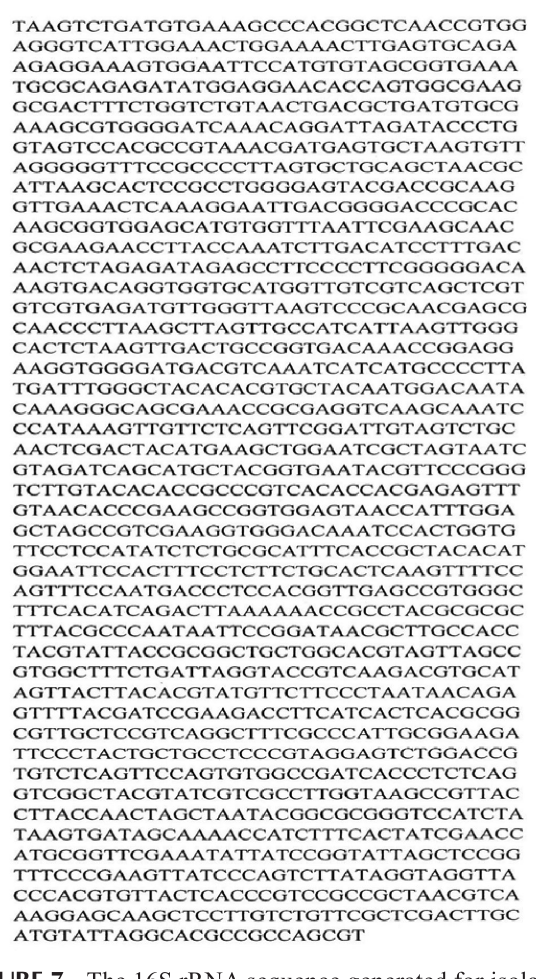
FIGURE 5 - The 16S rRNA sequence generated for isolate-3 had 1822 bases.